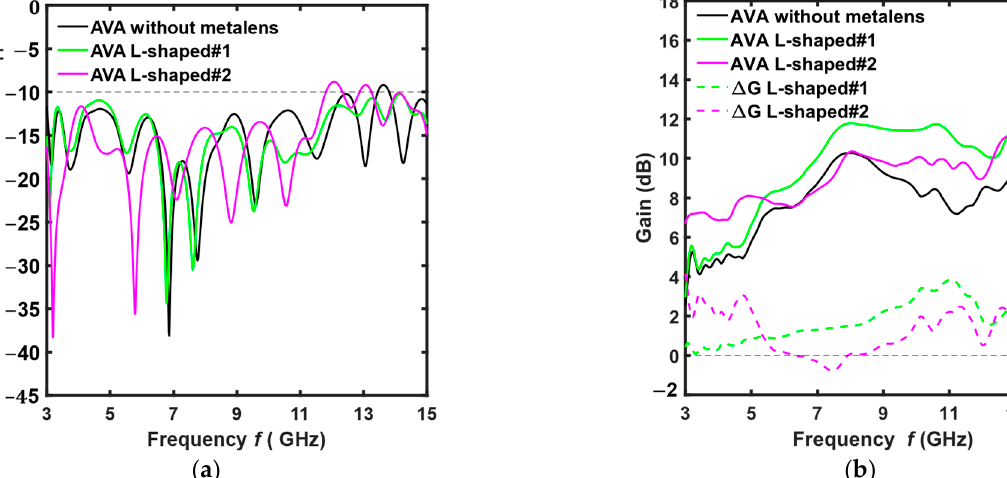
Figure 9. Full-wave simulation of the AVA with different L-shaped metalenses: ( a ) modulus of the scattering parameter | S 11 | as a function of frequency, and ( b ) realized gain G and gain increase ∆ G as a function of frequency.